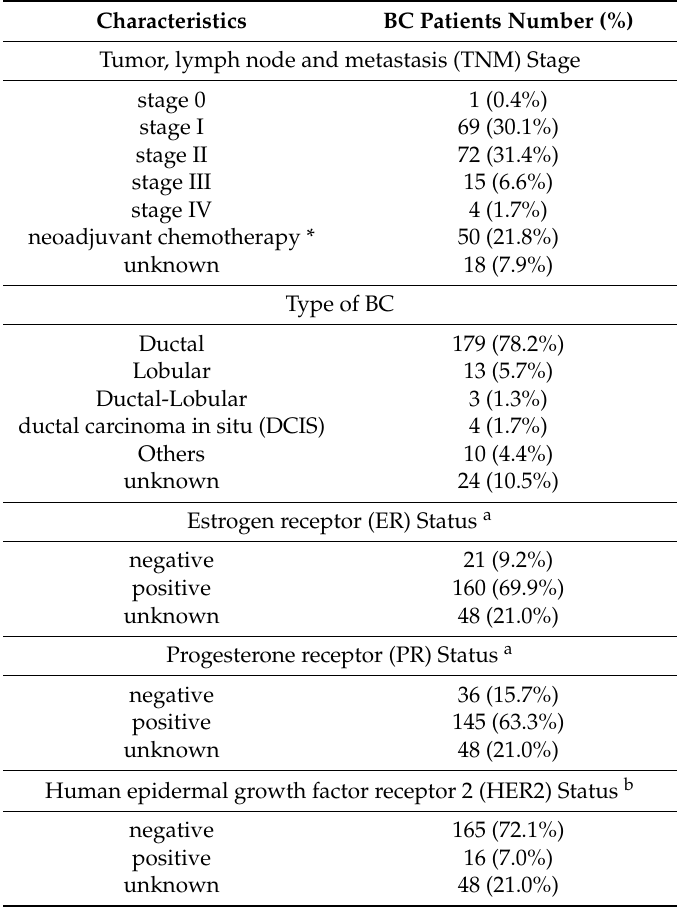
Table 3. Characteristics of the sporadic BC